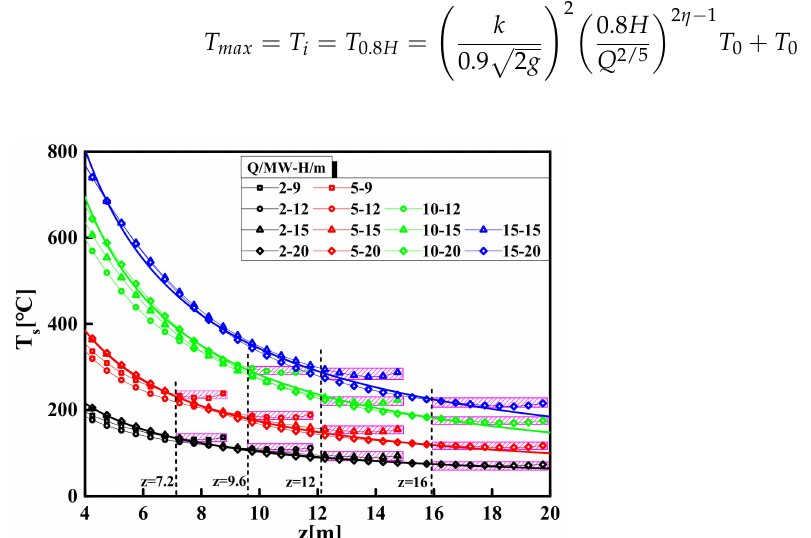
Figure 15. Temperature distribution laws of fire plume centerline in large-space